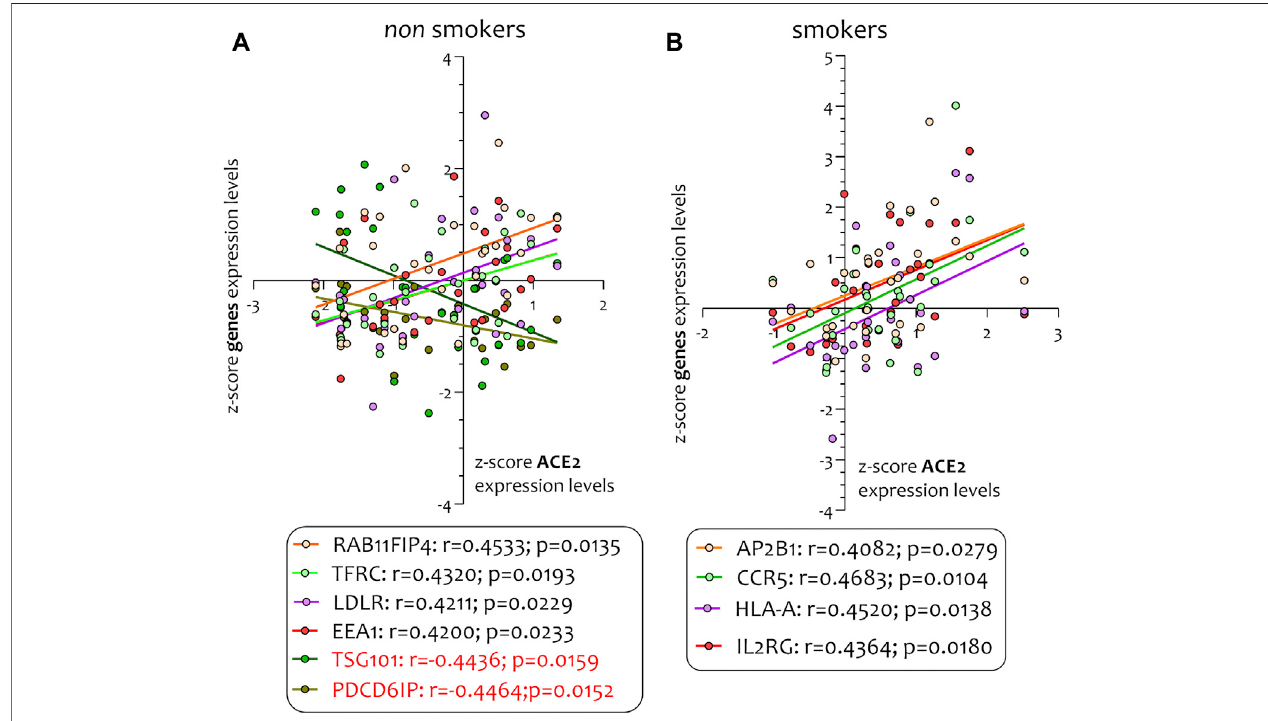
FIGURE8| Pearson ’ scorrelation analysisbetween ACE-2 anditsgenespathwaysinnon-smokers(PDCD6IP,TSG101,RAB11FIP4,LDLR,TFRC,andEEA1) (A) and smokers (AP2B1, CCR5, HLA-A, and IL2RG) (B) .